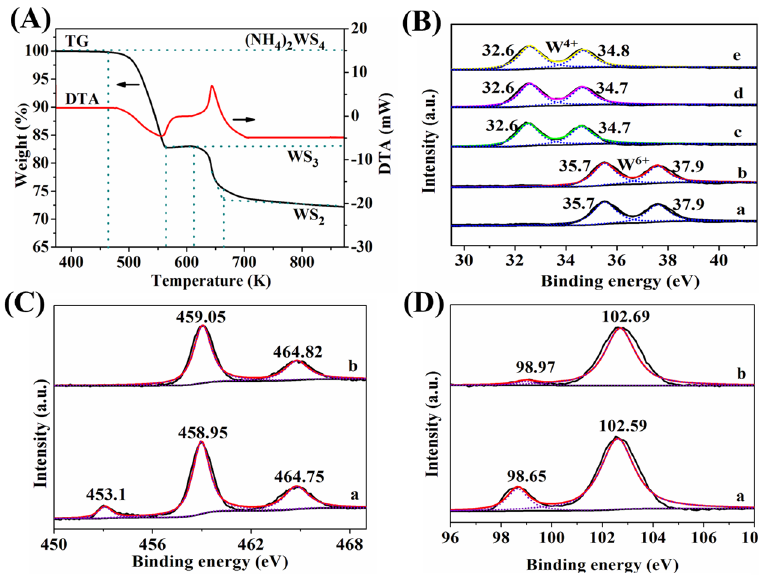
Figure 4. ( A ) TG ‐ TDA (thermogravimetric ‐ differential thermal analysis) curves of the decomposition Figure 4. ( A ) TG-TDA (thermogravimetric-differential thermal analysis) curves of the decomposition of (NH 4 ) 2 WS 4 ; ( B ) XPS spectra of the W 4f regions for WS 2 ‐ 1/TiSi 2 calcined at (a) 473, (b) 623, (c) 673, of (NH 4 ) 2 WS 4 ; ( B ) XPS spectra of the W 4f regions for WS 2 -1/TiSi 2 calcined at (a) 473, (b) 623, (c) 673, (d) 723 and (e) 773 K for 2 h; ( C ) High ‐ resolution XPS (X ‐ ray photoelectron spectroscopy) spectra of (d) 723 and (e) 773 K for 2 h; ( C ) High-resolution XPS (X-ray photoelectron spectroscopy) spectra of Ti 2p in (a) TiSi 2 and (b) WS 2 -1/TiSi 2 -723; ( D ) High-resolution XPS spectra of Si 2p in (a) TiSi 2 and (b) WS 2 -1/TiSi 2